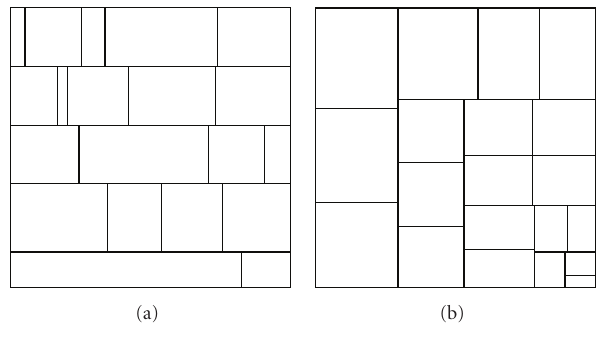
Figure 1: Original treemap (a) and squarified treemap (b).